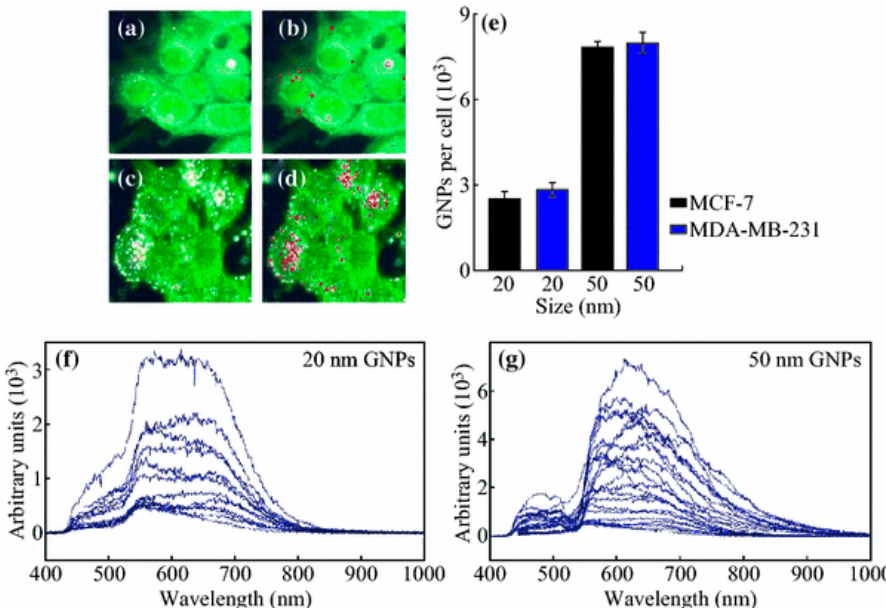
Figure 1. Uptake of gold nanoparticles (GNPs). Hyperspectral image of cell uptake of ( a ) 20-nm- and ( c ) 50-nm-sized GNPs; ( b , d ) GNPs clusters mapped using reflectance spectra of GNPs; ( e ) GNP internalization per cell for 20- and 50-nm-sized GNPs in two different cell lines. ( f , g ) The reflectance spectra of the 20- and 50-nm-sized GNPs in the monolayers ( a , c ). Reprinted with permission from [55]. Copyright 2016 Springer